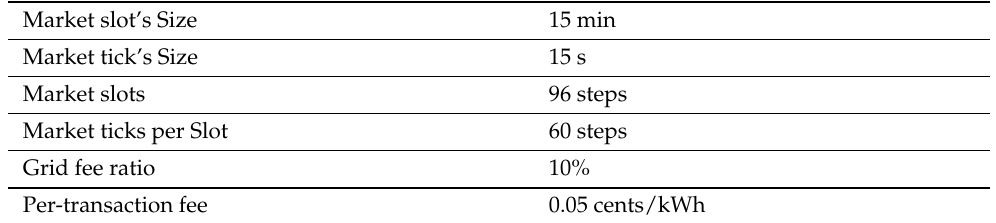
Table 2. Implemented Market